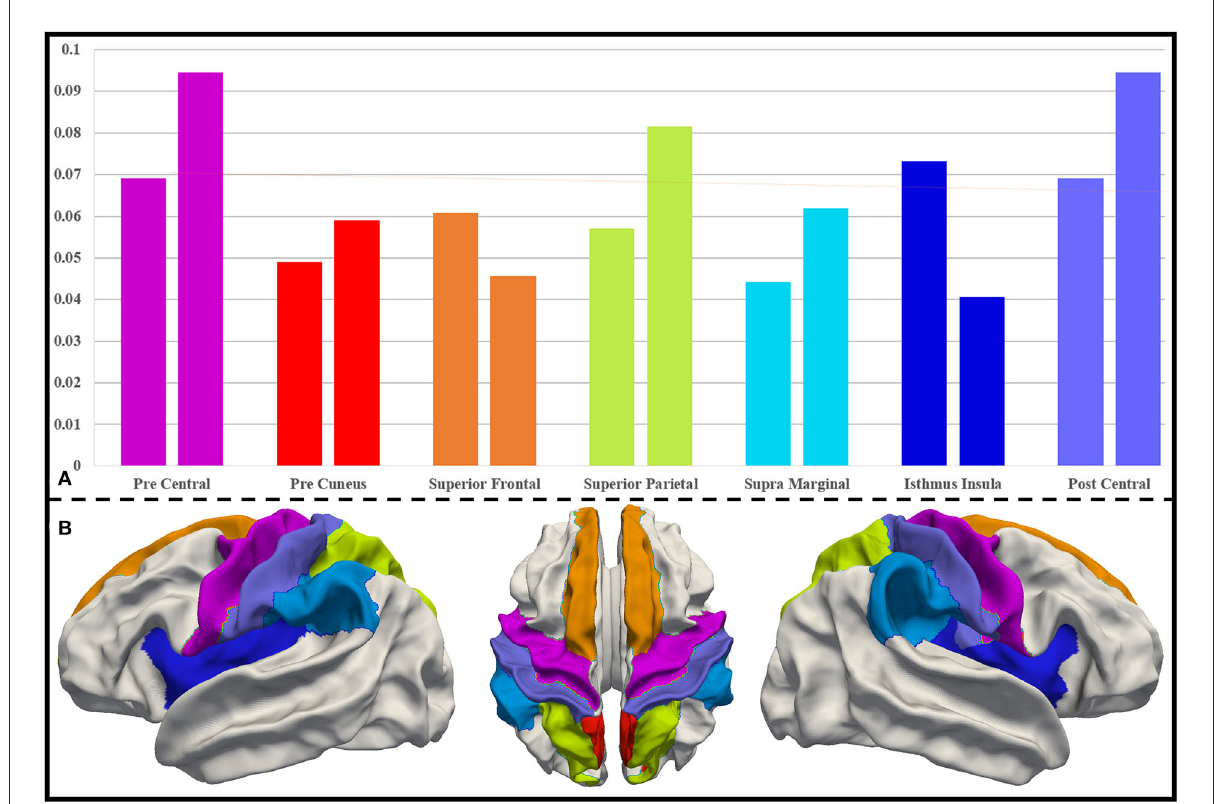
FIGURE5 (A) Distribution of DICCCOL landmarks in important brain regions for both schemes. For each pair of columns, the left side represents the distribution follow registration priority scheme, and the right side represents the distribution follow average priority scheme. (B) Important brain regions on the UNC infant cortical surface atlas, and the color of the brain regions corresponds to that in (A) .